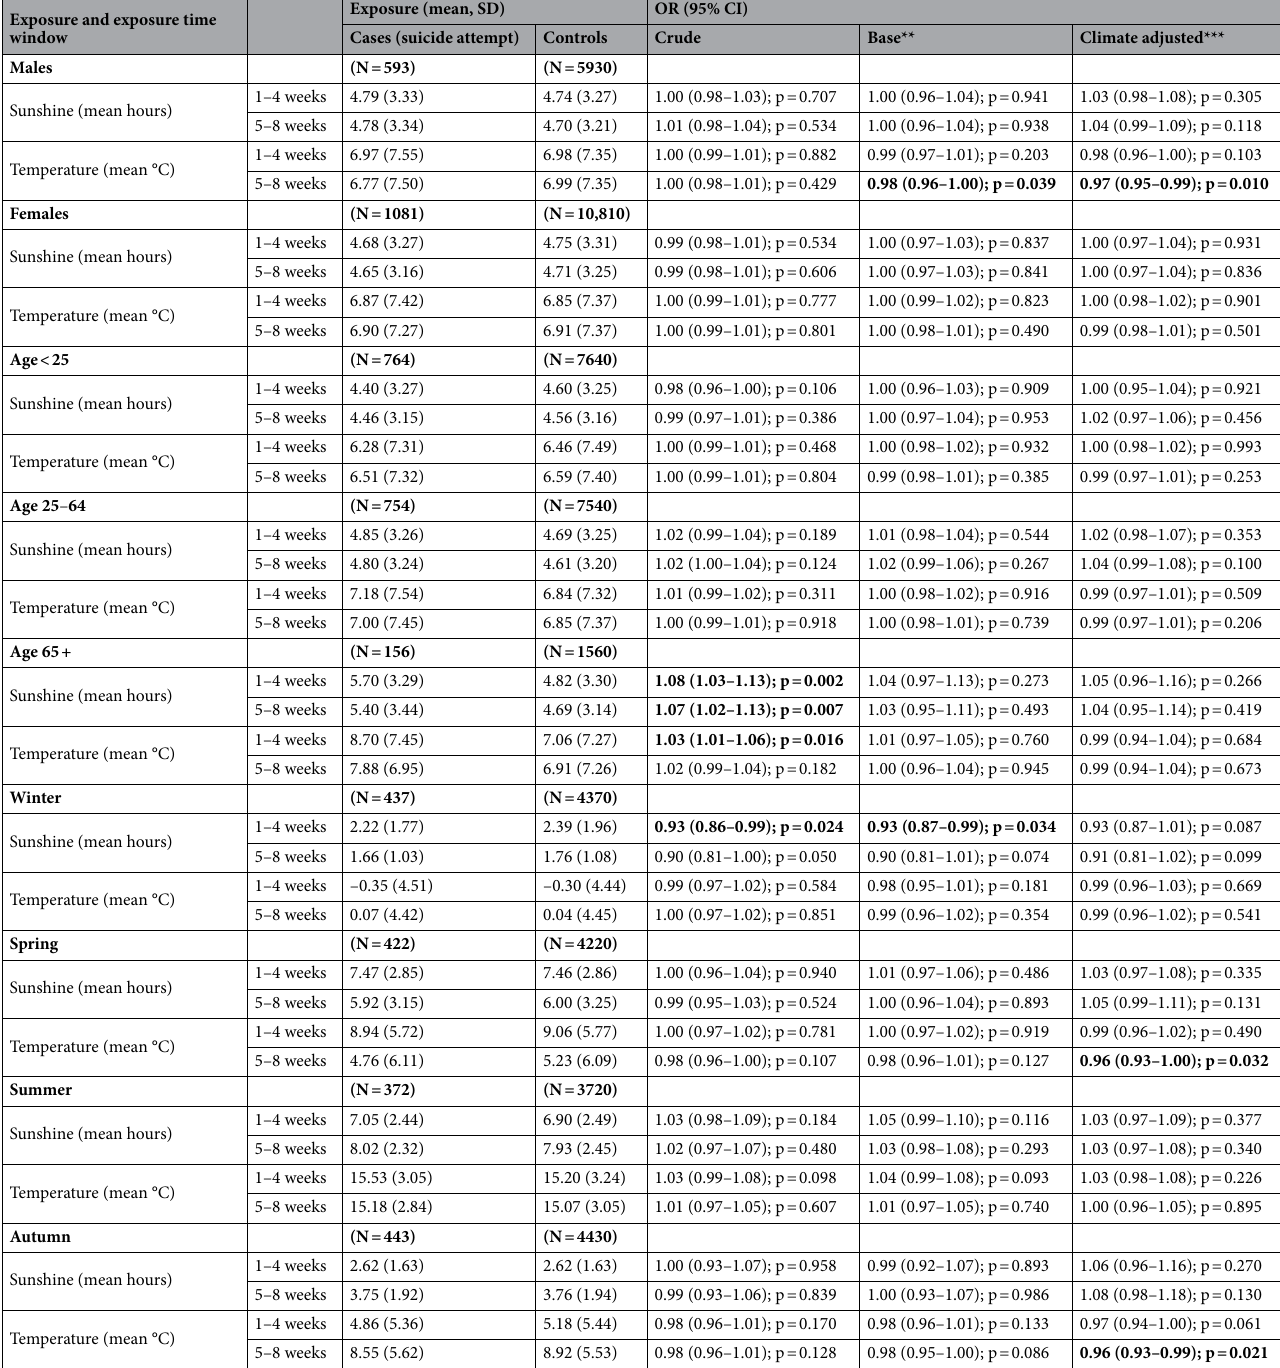
Table 5. Conditional logistic regression odds ratios (ORs) and 95% confidence intervals (95% CIs) for suicide attempt associated with sunshine hours and temperature during two exposure windows, by sex, age and season when the antidepressant treatment was started. Statistically significant results are given in bold. **Adjusted for previous suicide attempt, county, sex, age, year and season when the antidepressant treatment was initiated. ***Adjusted for all variables in Base model and temperature when sunshine was the exposure variable or sunshine when temperature was the exposure